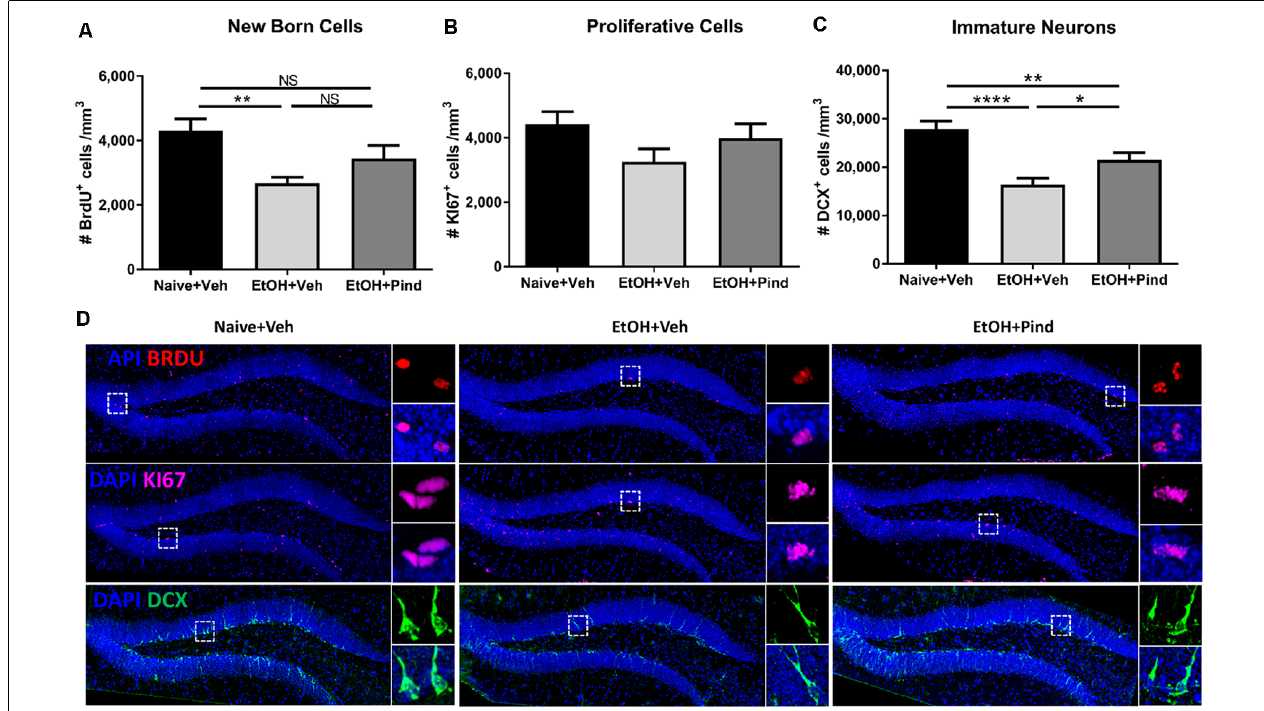
FIGURE 2 | Effects of pindolol on alcohol-induced deficits on markers of neurogenesis in mice. After 12 weeks of alcohol intake, mice were assigned to receive either pindolol (EtOH+Pin) or vehicle (EtOH+Veh). The alcohol naïve mice were assigned to receive a vehicle (Naïve+Veh). All mice received three injections of BrdU/week (150 mg/kg, i.p.) for 3 weeks which was administered at the end of the drinking session on Monday. Following their routine alcohol intake period of 2 h, the EtOH+Pin group received chronic pindolol (32 mg/kg/day), the EtOH+Veh group received chronic vehicle and the Naïve+Veh group received chronic vehicle injections for 2 weeks. The animals were allowed 1 week of alcohol intake after the last BrdU injection before sacrificing, n = 5–6 animals/group; six dentate gyri/animal. Long-term alcohol drinking reduces the density of BrdU-immunoreactive (BrdU + ) cells in the dentate gyrus (DG) of the hippocampus and chronic pindolol treatment has no effect on this impairment (A) . The density of Ki67-immunoreactive cells (Ki67 + ) is not affected by alcohol consumption or pindolol treatment (B) . Long-term chronic alcohol decreases the density of DCX-immunoreactive (DCX + ) immature neurons in the DG, and this reduction was only partially prevented by a chronic pindolol treatment, as compared to alcohol naive mice treated with vehicle (C) . Data are presented as mean density of cells per mm 3 of granular layer ± SEM; n = 5–6 mice/group, 3–4 dentate gyri/mouse. ∗ p < 0.05, ∗∗ p < 0.01; ∗∗∗∗ p < 0.0001 (one-way ANOVA followed by Bonferroni’s post hoc analysis). Representative confocal micrographs for the different markers (DAPI+BrdU; DAPI+KI67 and DAPI+DCX; scale bar = 300 µ m) are presented for different treatment groups (naïve+Veh, EtOH+veh and EtOH+Pind; D) . For each micrograph, a higher magnification view of the dash box (scale bar = 15 µ m) is presented on the right. ns = not significant, p >